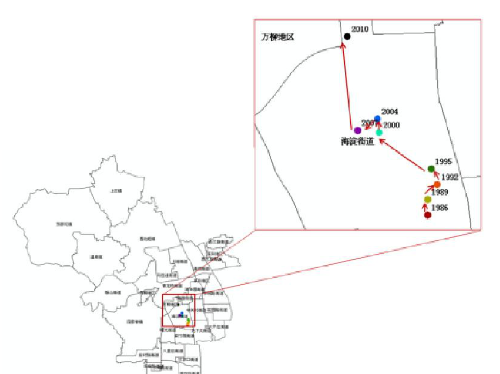
Figure. 7 Trajectories of city centroid by Landsat TM between 1986 and 2010, Haidian District